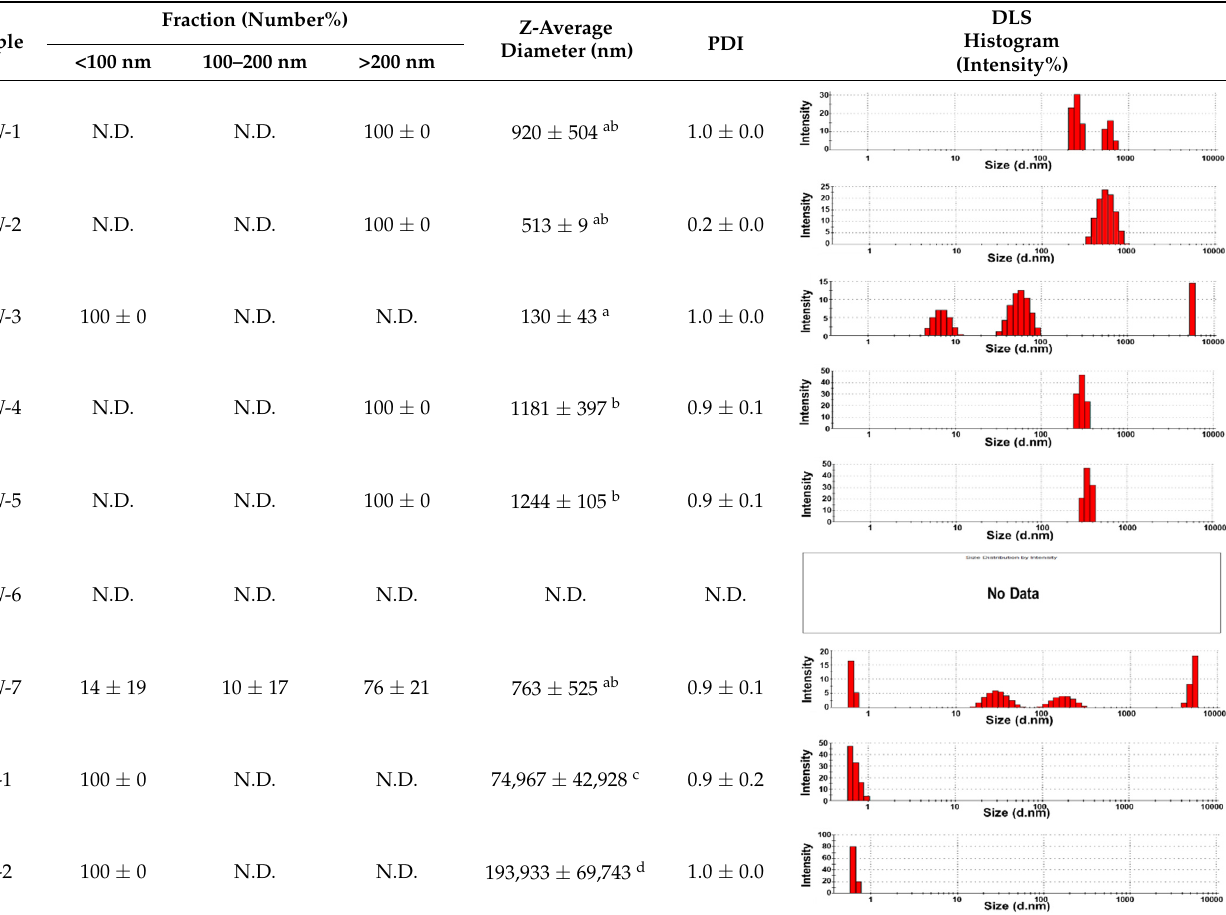
Table 1. Particle fractions and hydrodynamic diameters of bubbles in NBWs or in conventional SWs at 25 °C 1 . Sample